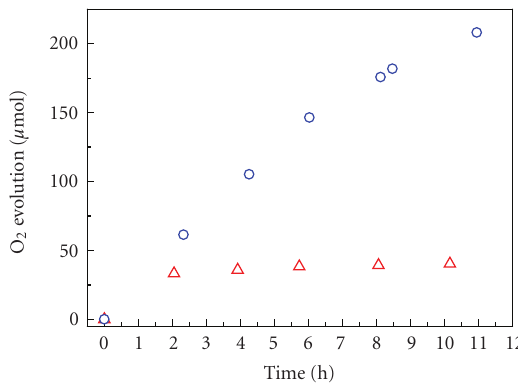
Figure 7: Photocatalytic O 2 evolution from aqueous solution (0.5g photocatalyst, 2mmol AgNO 3 , 400 ml H 2 O) without any cocatalyst under UV light irradiation. Light source: a 400 W high-pressure Hg lamp ◦ : La 1 / 3 NbO 3 ; (cid:2) : La 1 / 3 TaO 3